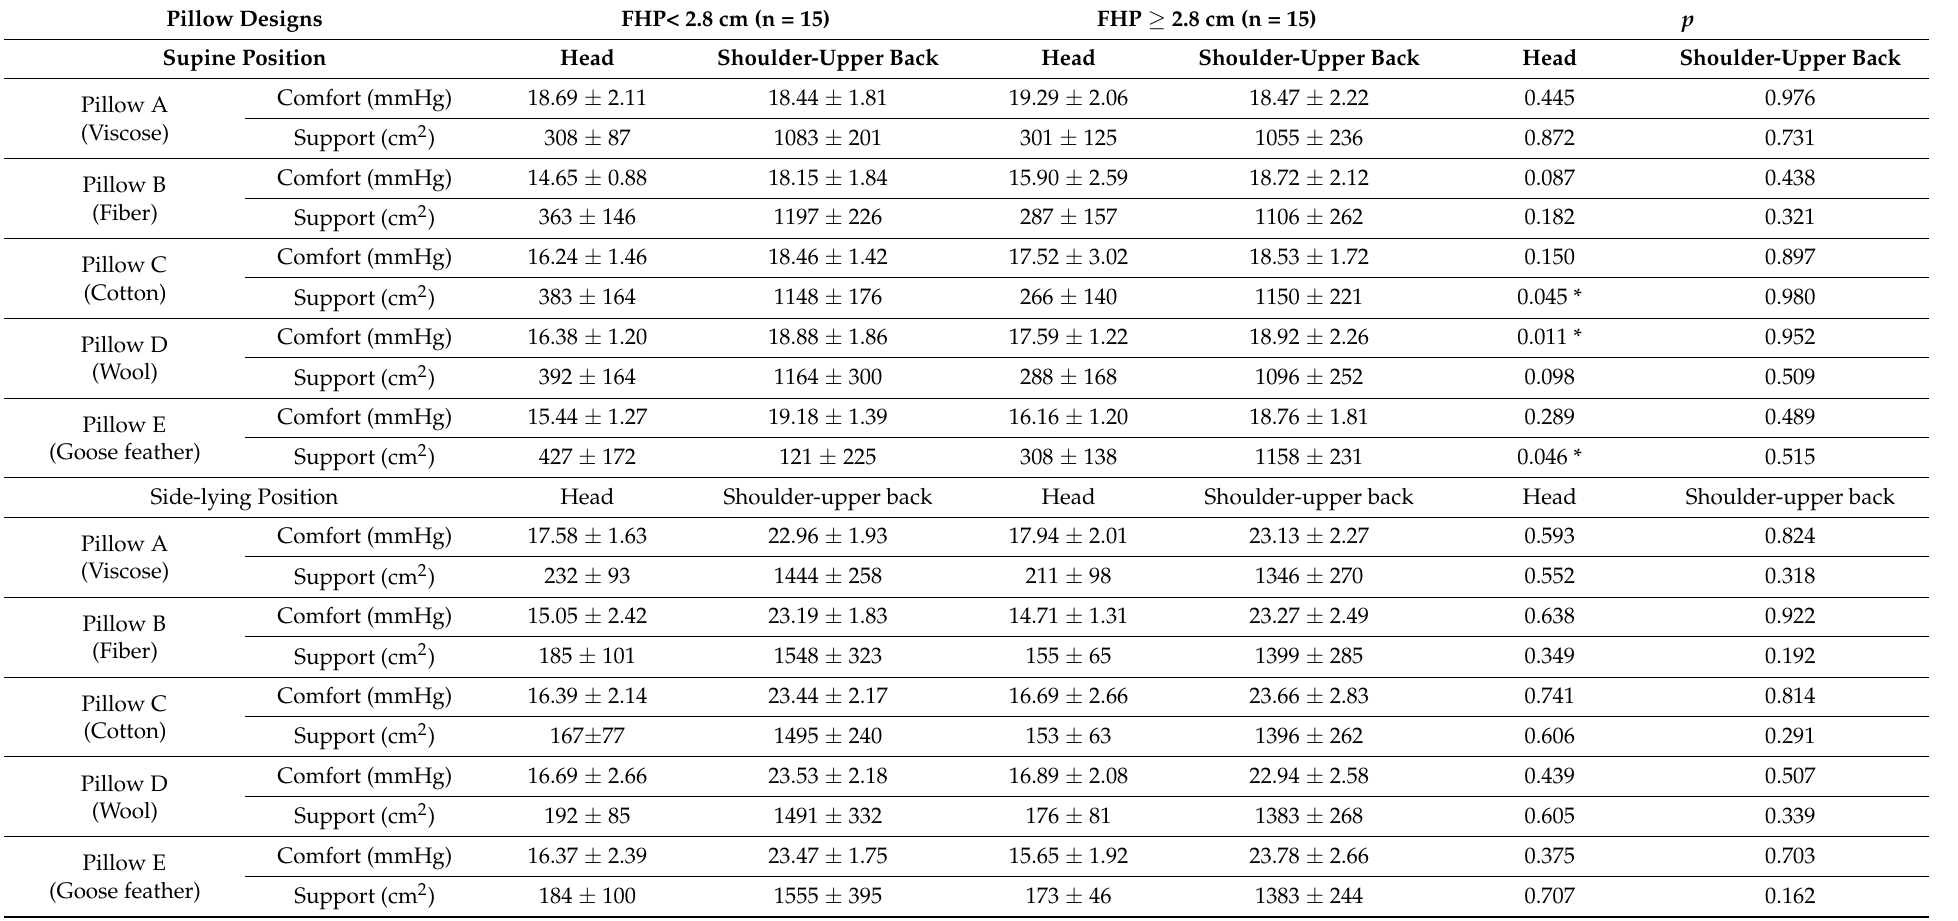
Table 3. Comfort and support values provided by different pillow designs according to the severity of